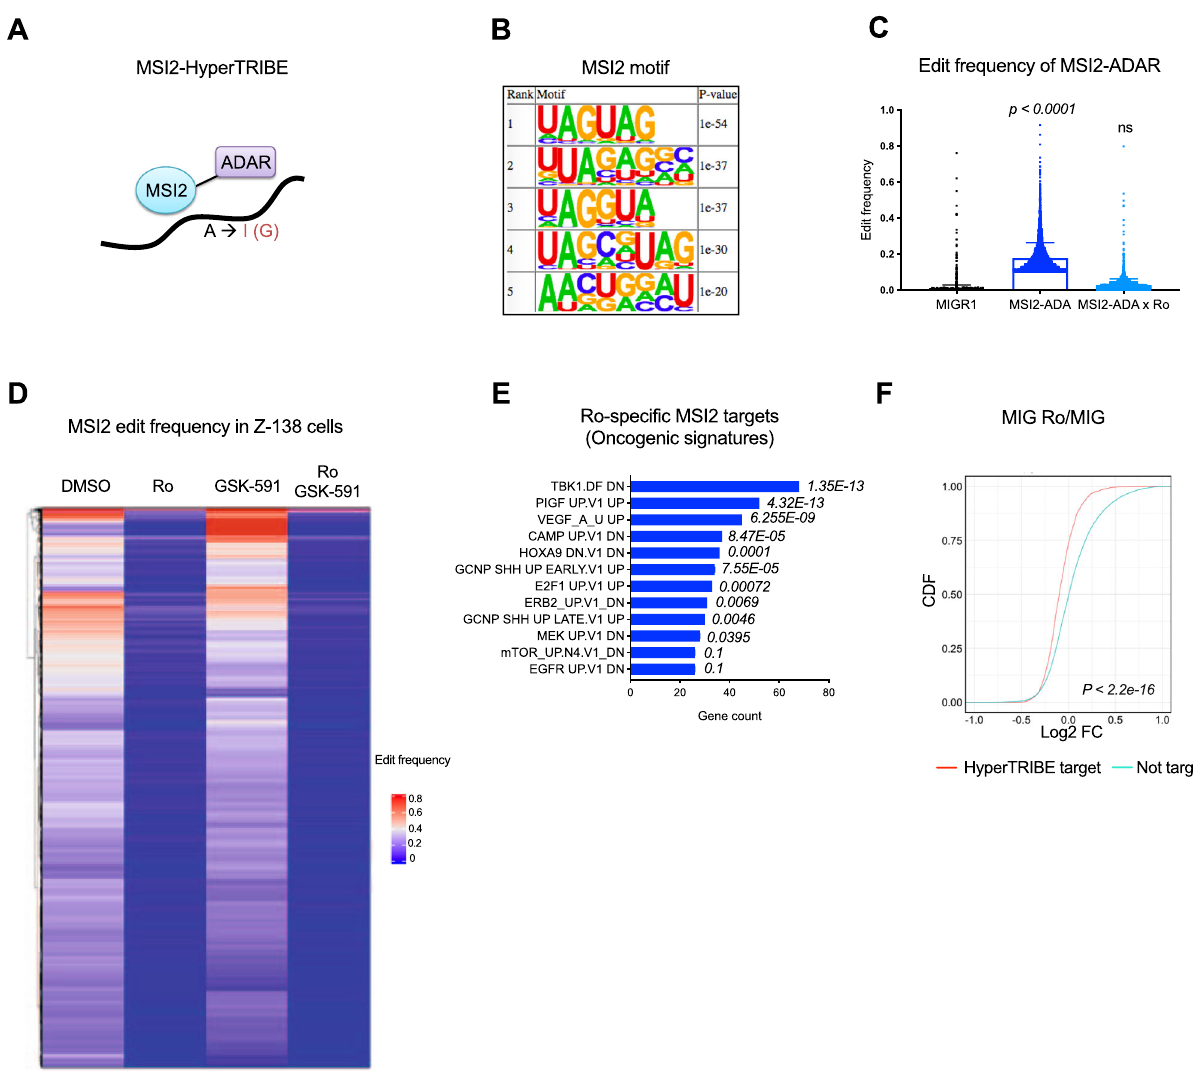
Fig. 6 | Ro blocks MSI2 mRNA binding and MSI2 binding speci fi city is PRMT5 independent. A Schematic illustration showing the MSI2 fusion to the ADAR cat- alytic domain. B HOMER motif enrichment was performed on ±100bp window fl anking both sides of the edit site, totaling a 200bp window per edit site. Top 5 motifs and the corresponding p -values are shown, statistical analysis by Fisher ’ s test. C Edit frequency on mRNAs in Z-138 cells overexpressing empty vector (MIG) or MSI2-ADAR and MSI2-ADAR treated with Ro for 24h. Unpaired Kruskal – Wallis test; p -value< 0.0001. D HeatmapofMSI2editfrequencyinZ-138cellstreatedwith Ro, GSK-591, or the combination for 24h. HyperTRIBE data was fi ltered to include